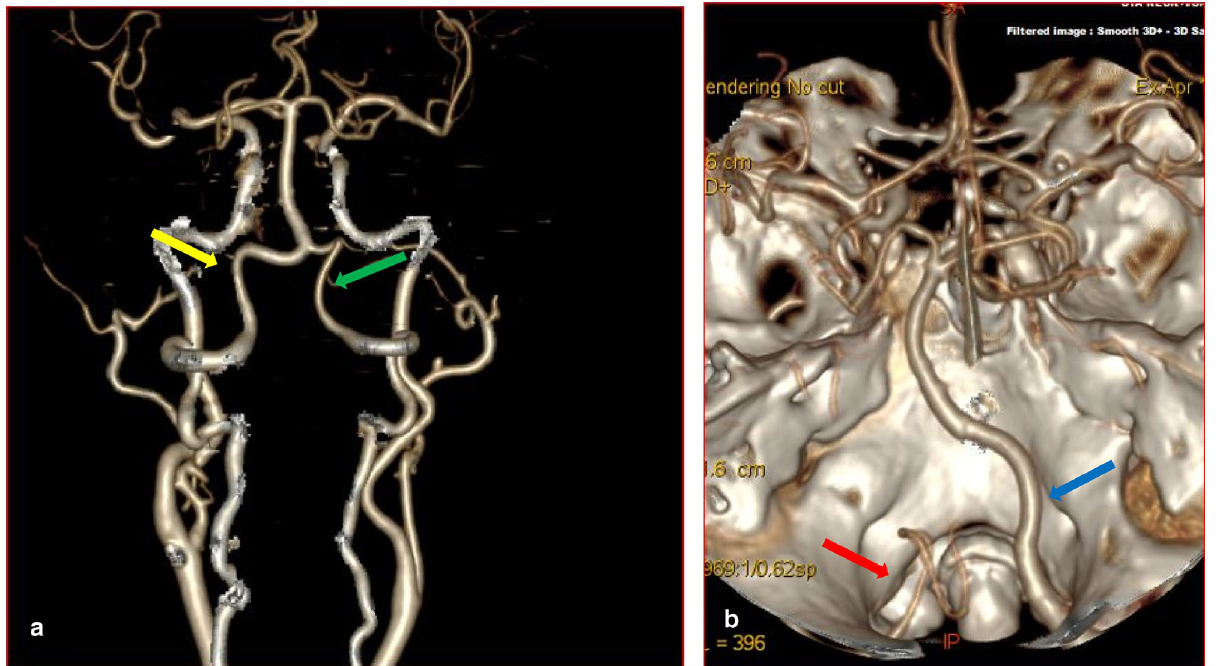
Figure 3. 3D-CTA reconstructed images showing the vertebral, the basilar arteries, and the Circle of Willis. ( a ) The yellow arrow illustrates the left dominant VA. The green arrow indicates hypoplastic right VA. ( b ) The red arrow illustrates termination of left VA as PICA. The blue arrow indicates dominant right